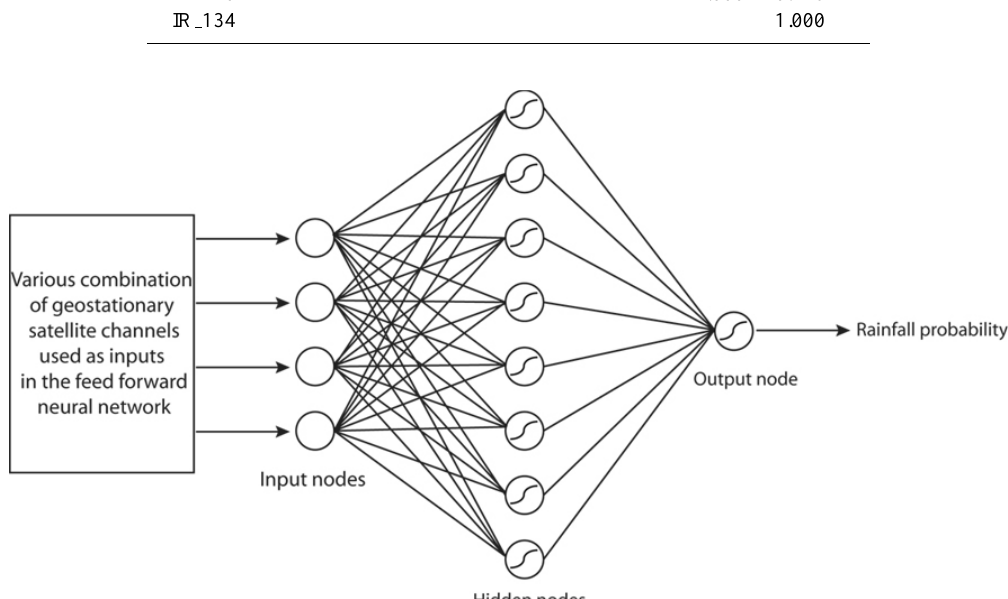
Fig. 4. Schematic representation of a feed forward neural